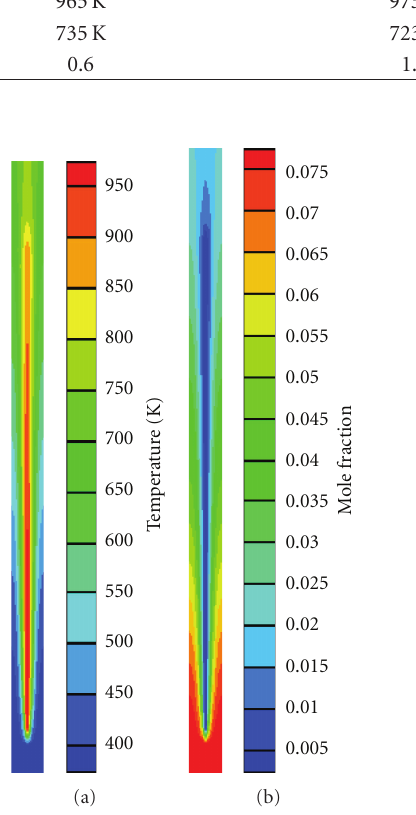
Figure 16: (a) Temperature contour and (b) hydrogen mole fraction contour zoomed view near catalyst plate second steady state condition